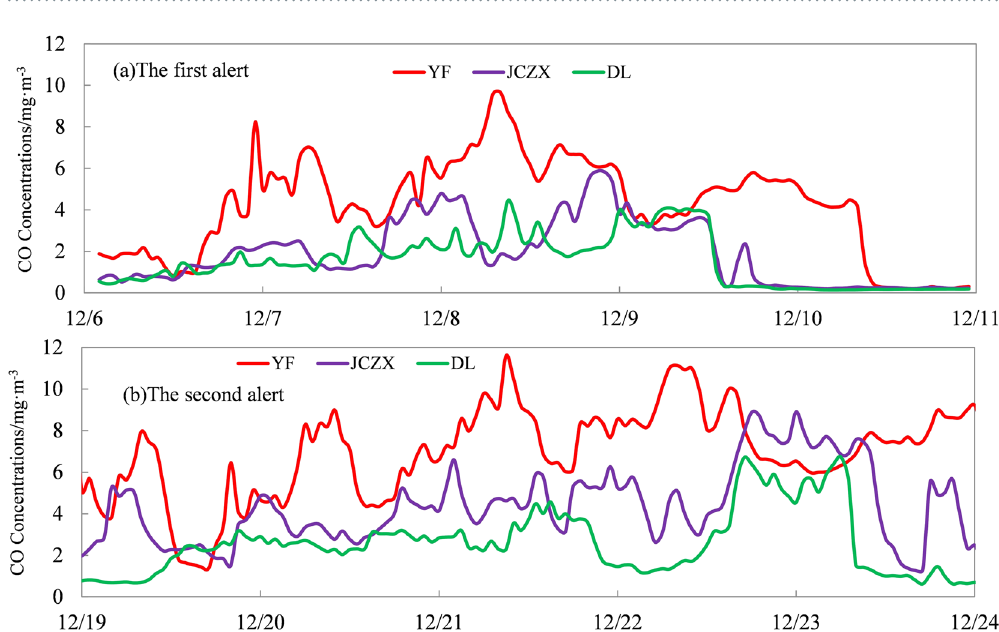
Figure 3. Variations of hourly averaged CO concentrations at 3 representative stations in Beijing during two red